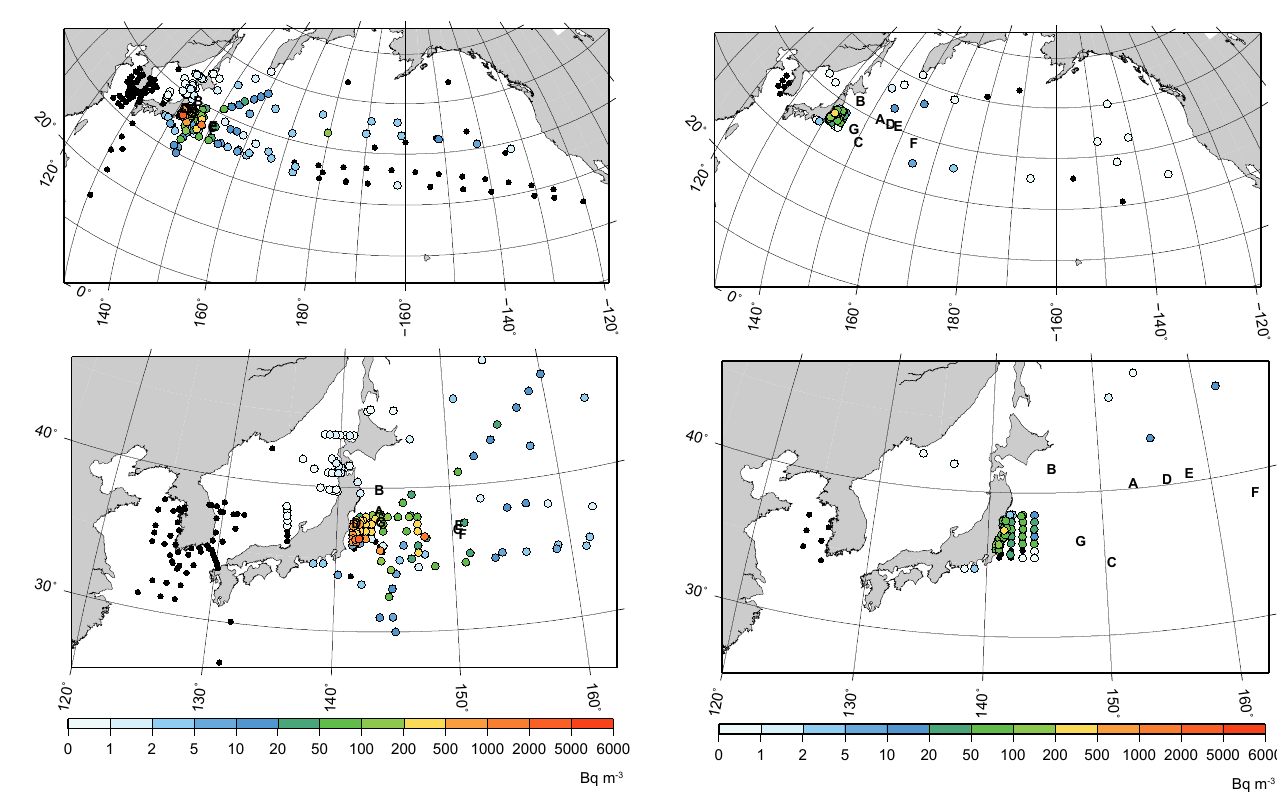
Fig. 2. 134 Cs activity in the surface water during the period from July 2011 to September 2011 for the North Pacific Ocean (upper) and close to Japan (lower). Positions of Argo floats on 15 August 2011 are marked